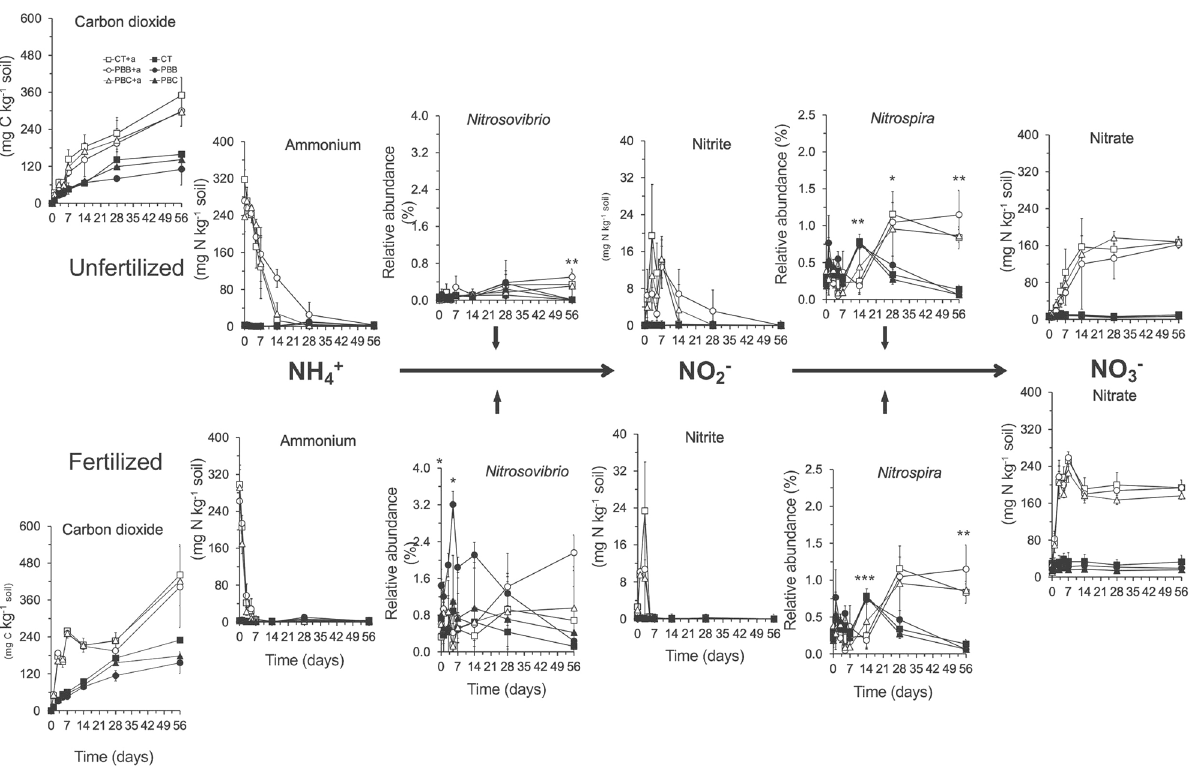
Figure 1. Emission of carbon dioxide (mg C kg −1 ), concentration of ammonium (NH 4 + ), nitrite and nitrate (mg N kg −1 soil), and the relative abundance (%) of the ammonium oxidizer Nitrosovibrio and nitrite oxidizer Nitrospira in the unfertilized soil and soil fertilized with 300 kg urea-N ha −1 with conventional tilled beds and crop residue retained (CT) left unamended (filled black square) or amended with 300 mg NH 4 + -N (open square), permanent beds with crop residue burned (PBB) left unamended (filled black circle) or amended with 300 mg NH 4 + -N (open circle) and permanent beds with crop residue retained (PBC) incubated left unamended (filled black triangle) or amended with 300 mg NH 4 + -N (open triangle) incubated aerobically at 25 ± 2 °C for 56 days. A non-parametric test (aldex.kw function; Kruskal Wallis test) in the ALDEx2 package 14 was used to determine the effect of application of 300 mg NH 4 + -N on the relative abundance of the Nitrosovibrio and Nitrospira using the centered-log-ratio transformed counts, i.e. clr-transformation, on the different sampling days with *** P < 0.001, ** P < 0.01 and P ≥ 0.001, and * P < 0.05 P ≥ groups was affected in a similar way, but the effect was mostly smaller in the fertilized than in the unfertilized soil. Some bacterial groups in the N fertilized soil also responded more rapidly to the application of ammonium tion of NH 4+ , compared to the unamended soil in both the fertilized and unfertilized soil, i.e. Achromobacter, Acinetobacter, Enterobacter, Flavisolibacter , Pseudomonas Rheinheimera (Figs. 4 and S5). Sometimes the relative abundance of the bacterial genus showed a sharp increase on only one day when NH 4+ was applied compared